Question: What visual encoding does this figure use to show its data?
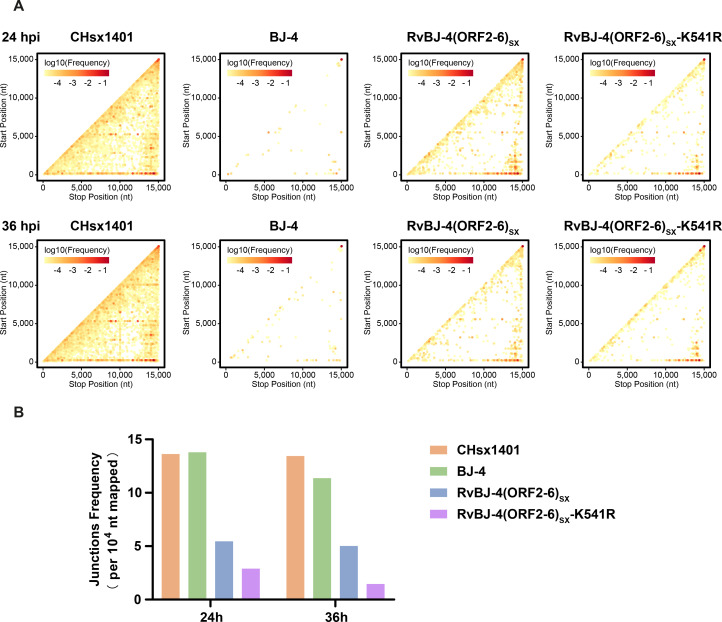
Answer: scatter